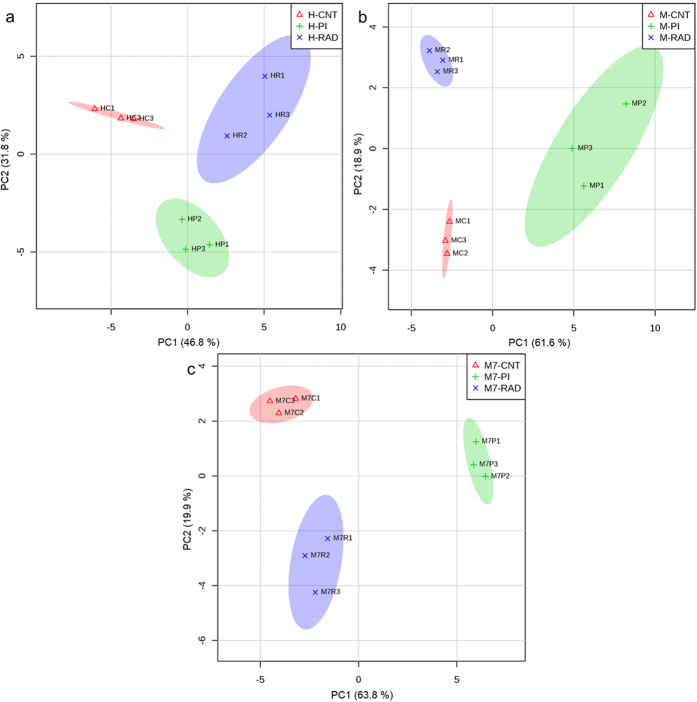
Principal component analysis of metabolite concentrations in (a) HCC1937, (b) MDAMB231 and (c) MCF7 cell lines. The cells were cultured in triplicate to ~80% confluence and treated with 50 μM ABT-888 (or DMSO) in fresh medium. For radiation treatment, cells were preconditioned with fresh medium for 24 hours prior to radiation treatment with 8 Gy dosage. The samples were collected as described in the methods and analyzed using ChenomX Profiler. Metabolite concentrations were normalized and auto-scaled prior to PCA using MetaboAnalyst. Each data point represents a biological sample and ellipses indicate the 95% confidence intervals. Abbreviations: PI: PARP inhibition, RAD: radiation, H: HCC1937, M: MDAMB231, M7: MCF7, CNT: control.